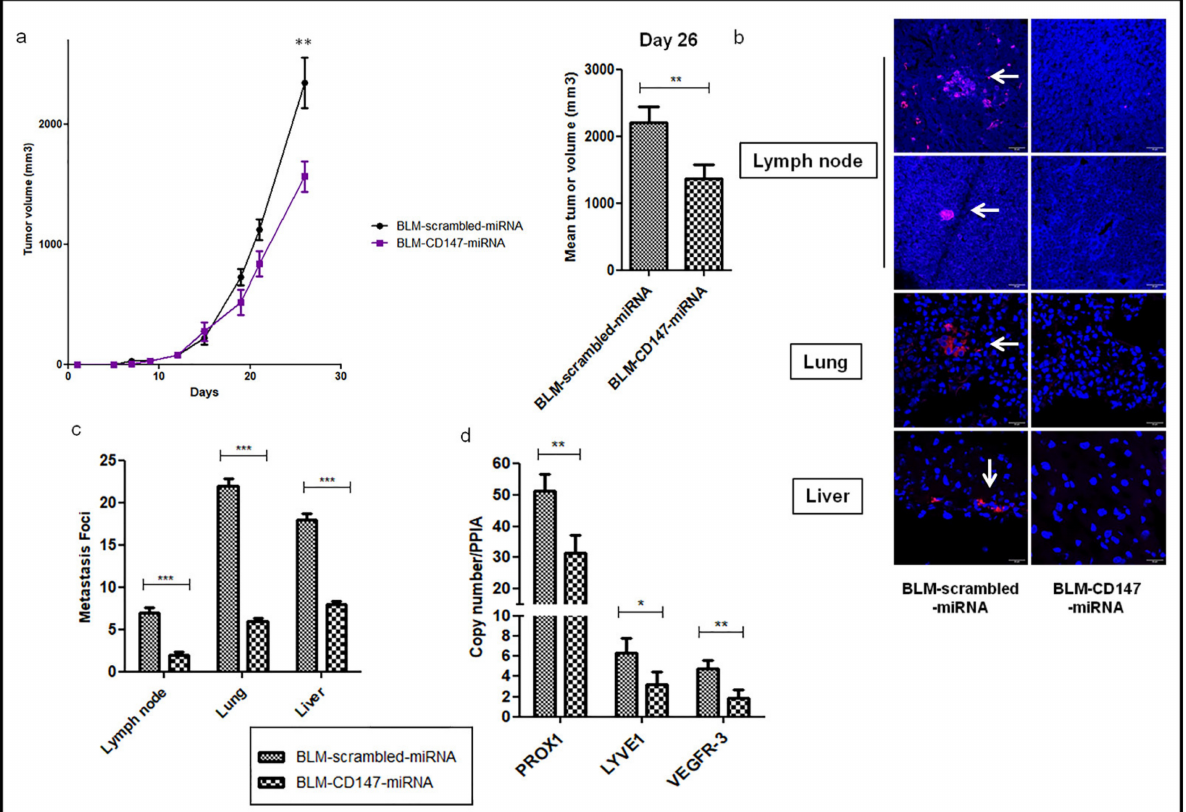
Figure 6. CD147 downregulation reduces tumor growth and metastasis formation in human melanoma. ( a ) In vivo xenograft growth. BLM-scrambled and BLM-CD147-miRNAs were inoculated in nude mice for 26 days. Results represent two independent experiments with 10 mice in each group. Columns represent means of tumor volume at sacrifice. Bars; SEM, ** p < 0.005. ( b ) Representative images of confocal fluorescent micro-metastasis (white arrows) in mice’s lymph node, lung and liver. 40x Magnification. Scale bar: 20 µ m. ( c ) Quantification of the micro-metastatic foci in mice lymph nodes, lungs, and livers. ( d ) qRT-PCR of PROX1 , LYVE-1 , and VEGFR3 expression in BLM-scrambled or BLM-CD147-miRNAs tumors, using PPIA as a reference. Columns indicate means of three independent experiments carried out in triplicate; and bars, SD; * p < 0.05, ** p < 0.005, *** p <